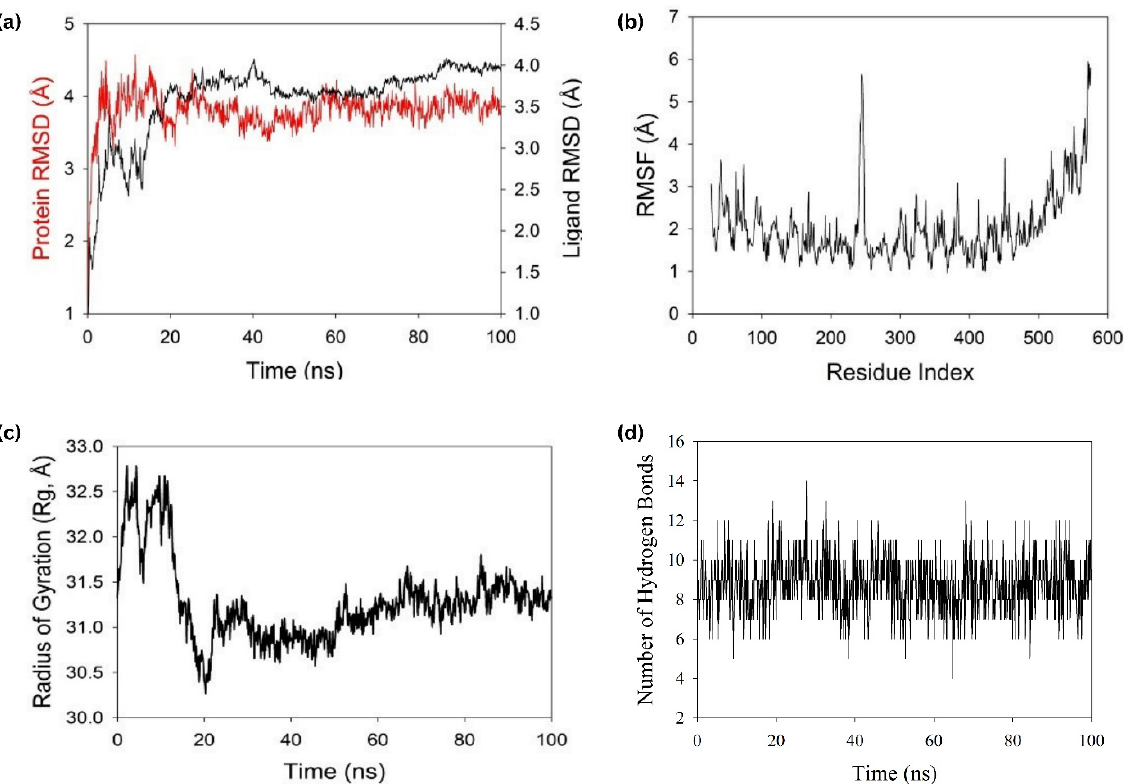
Figure 10. Analysis of MD simulation trajectories for 100 ns. ( a ) RMSD plot displaying. the molecular vibration of C α backbone of protein (red) and ligand (black). ( b ) RMSF plot showing the fluctuations of respective amino acids throughout the simulation time 100 ns for protein. ( c ) Radius of gyration plots for the deduction of compactness of protein. ( d ) Number of hydrogen bonds formed between protein and ligand during 100 ns simulation time scale. Table 6. Formation of hydrogen bonds and salt bridges and their number with respective amino acid residues between protein and ligand–protein. Residue Closest Distance Specific Interactions H.B. Salt Bridges